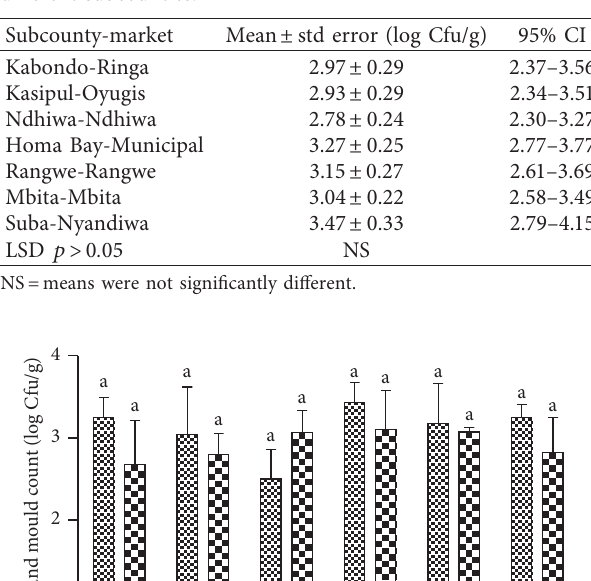
Table 2: Mean yeast and mould count of cassava products in different subcounties.